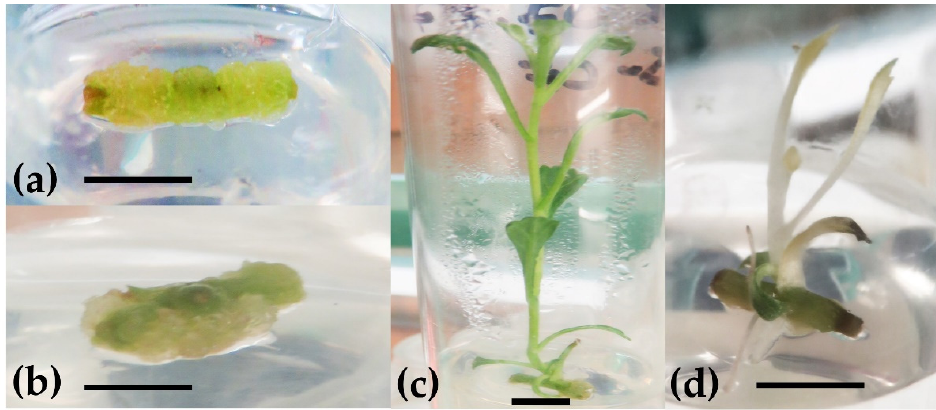
Figure 4. Morphogenetic responses of internode explants after 15 days of their incubation: ( a ) BAP (0.1 mg/L) with NAA (1.0 mg/L), ( b ) KIN (0.1 mg/L) with 2,4-D (1.0 mg/L), ( c ) BAP (0.1 mg/L) with IAA (0.1 mg/L), ( d ) BAP (0.1 mg/L) with PIC (0.1 mg/L). Scale bar = 10 mm.